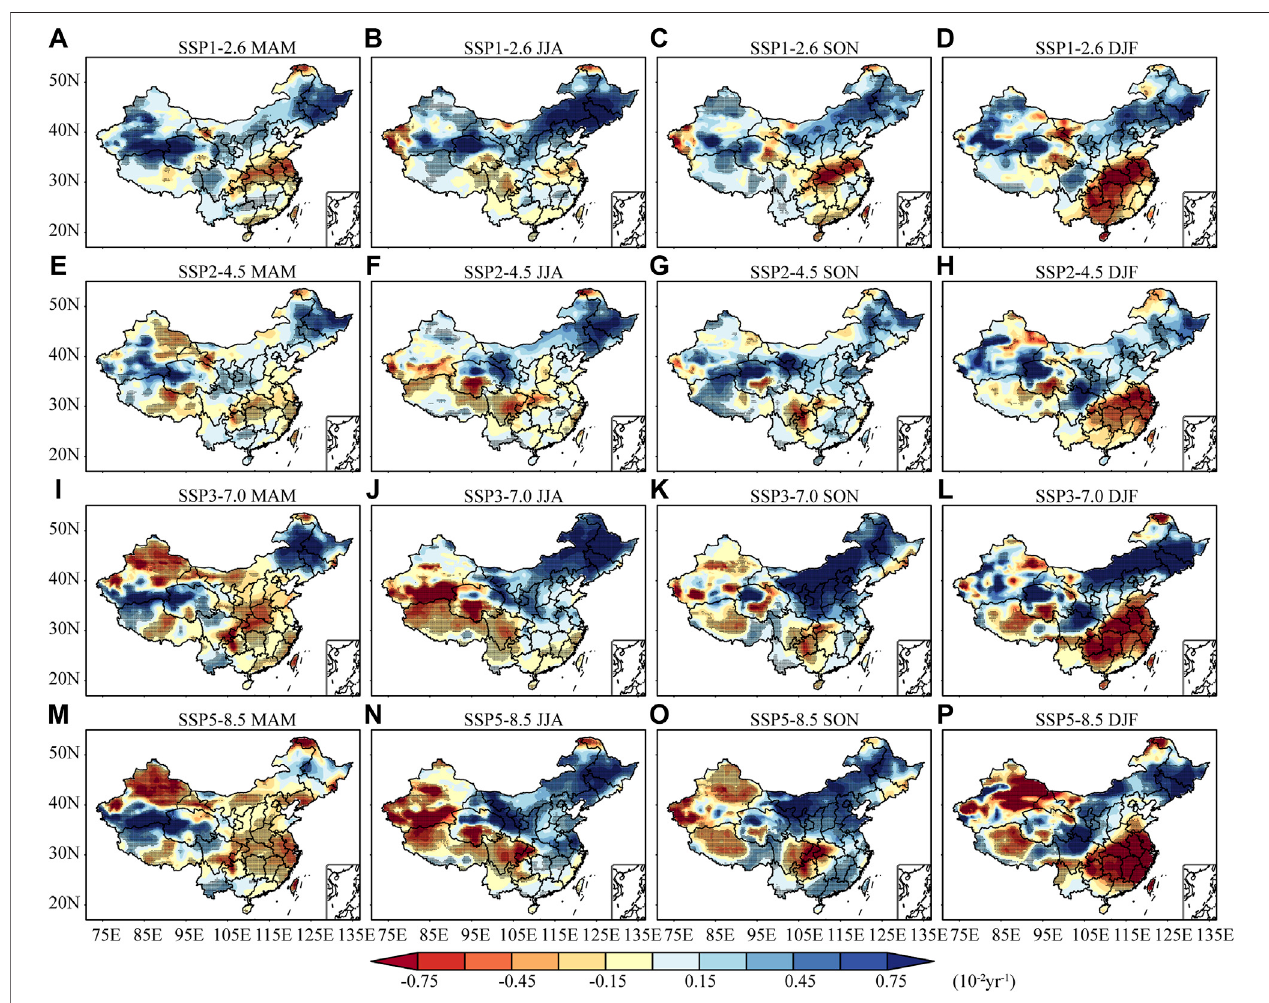
FIGURE7| SpatialdistributionsoftheannualmeanSSMItrendonfourfuturescenariosandseasonal,temporalscalein2015 – 2100forCMIP6 DL inChina.Thedots indicate the trend passing the 5% signi fi cance test.